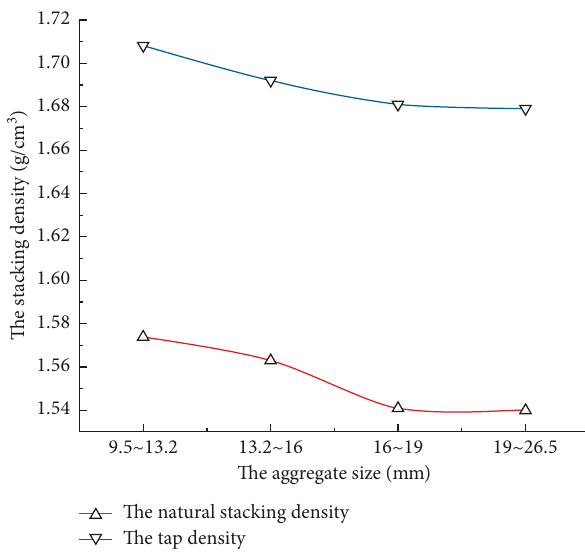
Figure 1: Summary of coarse aggregate density of test results.